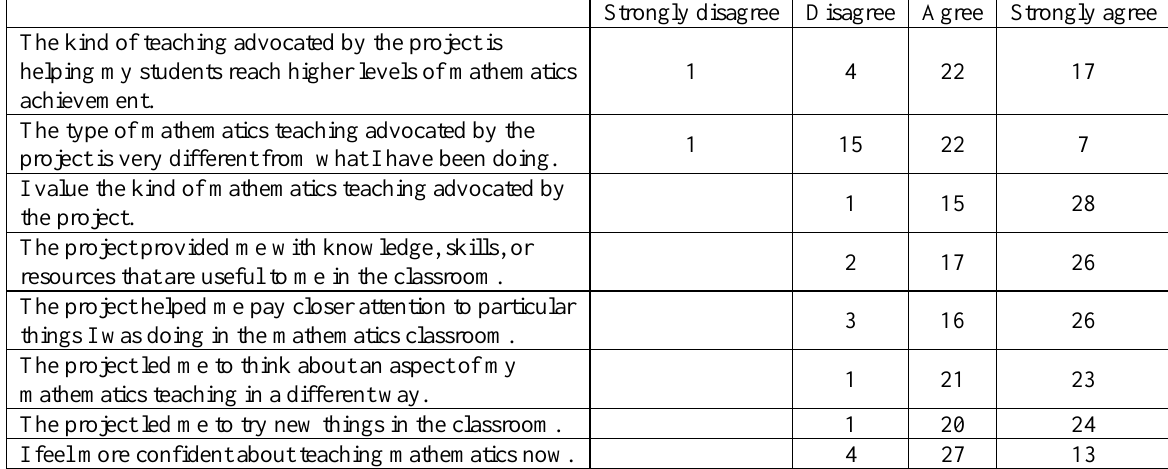
Table 3: Teacher